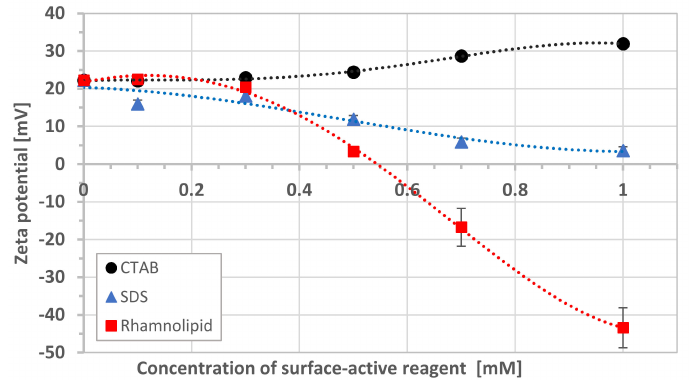
Figure 3. The zeta potential of schwertmannite in the presence of cetyltrimethylammonium bromide (CTAB), sodium dodecyl sulfate (SDS), and rhamnolipid (ionic strength 10 − 3 M NaCl, pH